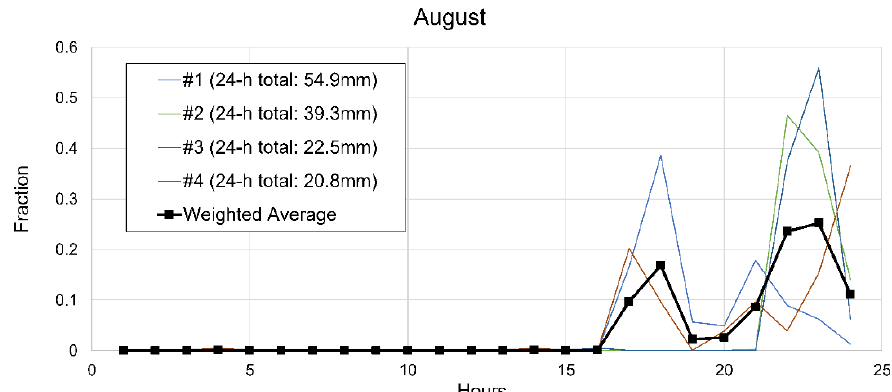
Figure 5. Weighted average temporal distribution of the 24-h design storm derived from the top four storms for August.